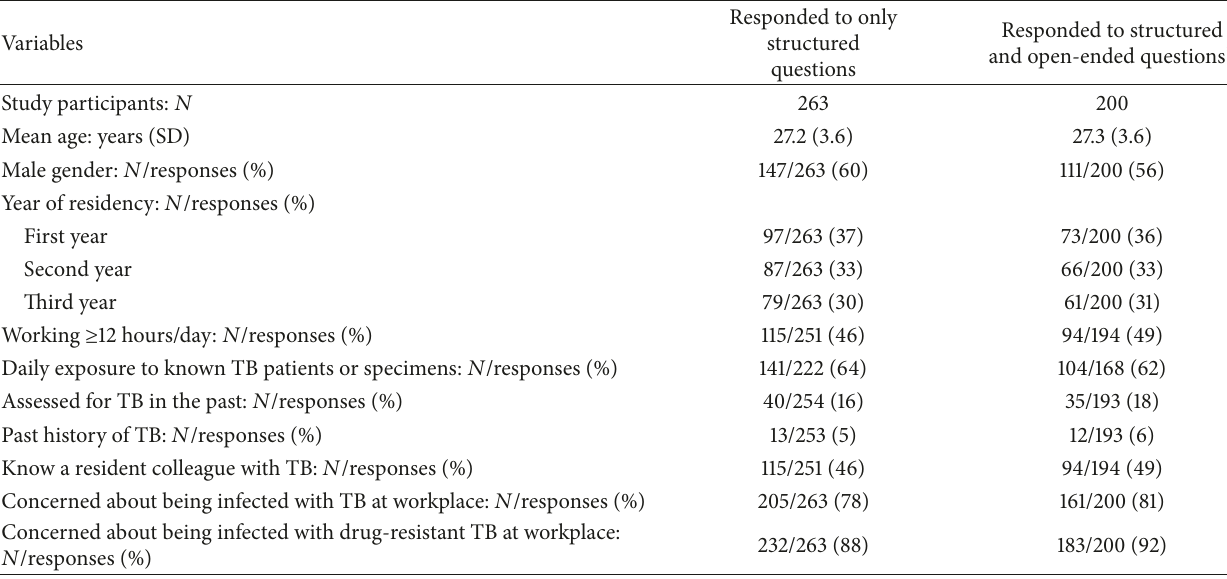
Table 1: Characteristics of medical residents responding to TB risk questionnaire.